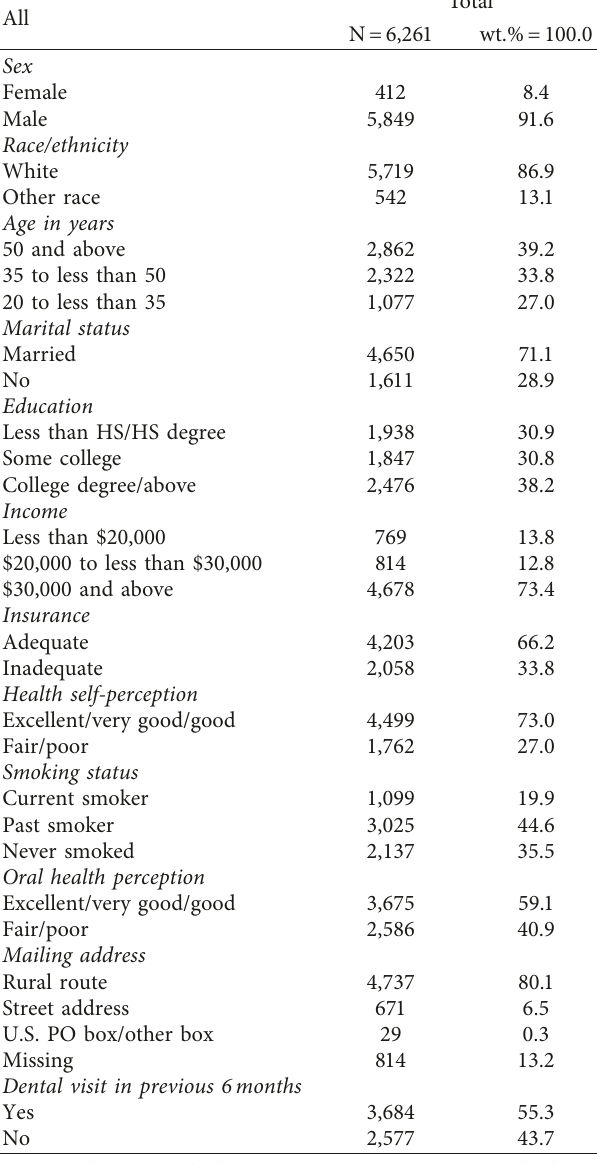
Table 1: Sample characteristics of veterans from the National Survey of Veterans,